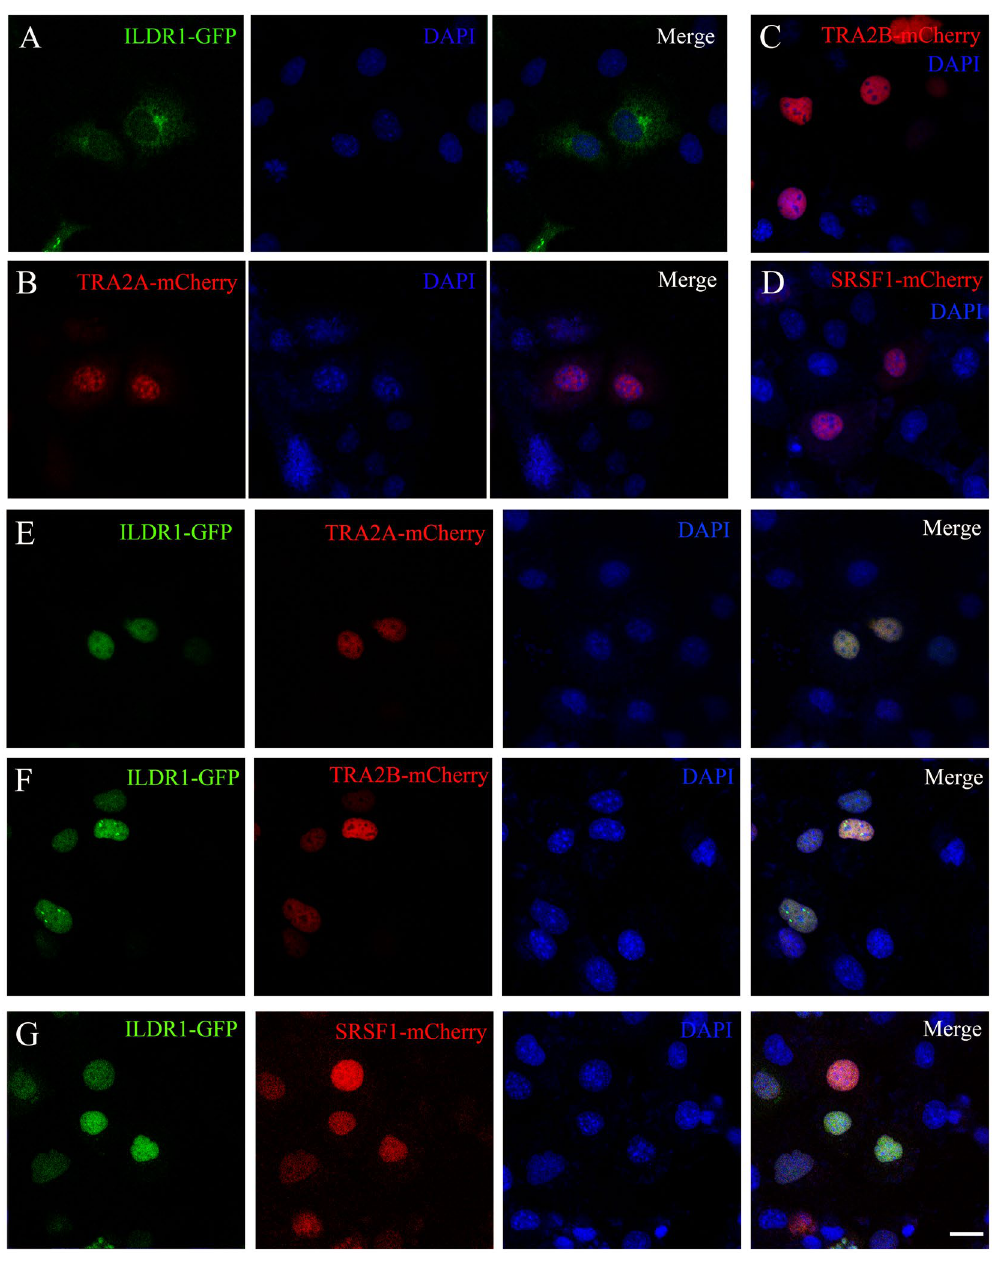
Figure 2. ILDR1 translocates into the nuclei when TRA2A, TRA2B, or SRSF1 is present. ( A ) ILDR1-GFP localizes in the cytoplasm. ( B–D ) TRA2A-mCherry, TRA2B-mCherry, and SRSF1-mCherry localize in the nuclei. ( E–G ) When cotransfected, ILDR1-GFP moves into the nuclei, colocalizing with TRA2A-mCherry, TRA2B-mCherry, or SRSF1-mCherry. Expression vectors were transfected into COS-7 cells to express epitope- tagged proteins. Nuclei were stained with DAPI. Scale bar: 20 μ